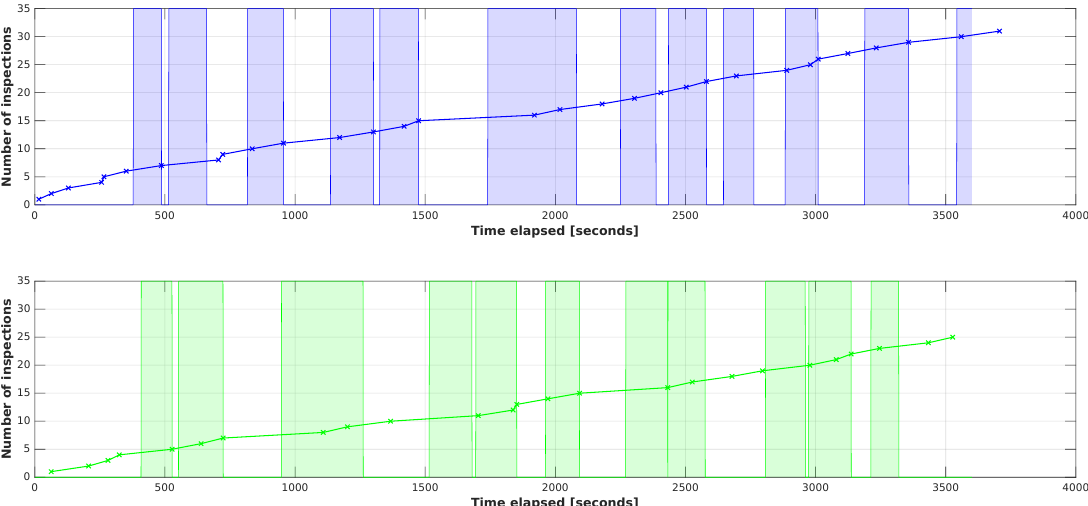
Figure 16. System recharging periods ( shaded areas ) overlapped with the number of inspections ( solid line ). Blue color—GSPNR policy; Green color—handcrafted